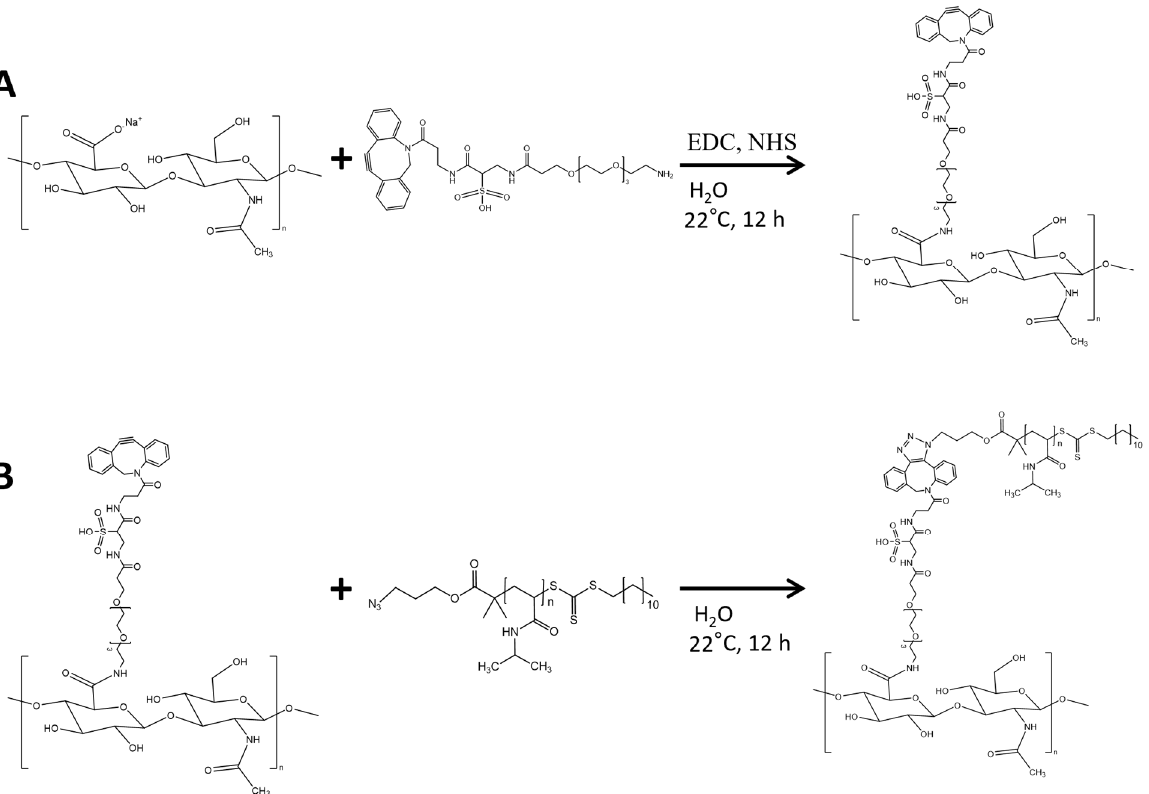
Figure 1. Synthetic route of HA-L-PNIPAM. Amidation reaction ( A ) and copper-free azide-DBCO click chemistry reaction ( B ).